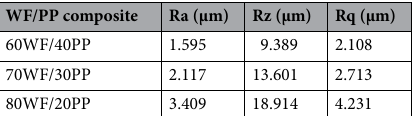
Table 3. Surface roughness of WF/PP base board.